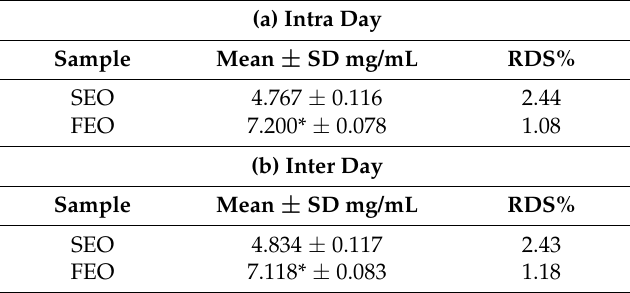
Table 1. Thymoquinone concentrations (mg/mL) in stored extracted oil (SEO) and fresh extracted oil (FEO). Intra Day (a) and Inter Day (b)